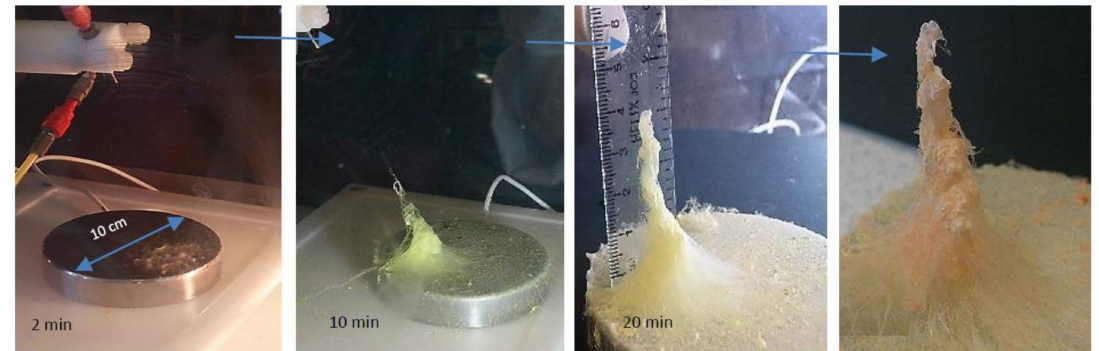
Figure 2. The process of fabrication of the 3D fiber stacks (due to color retention failure using various instruments, the real shade of fibers is slightly changed in some